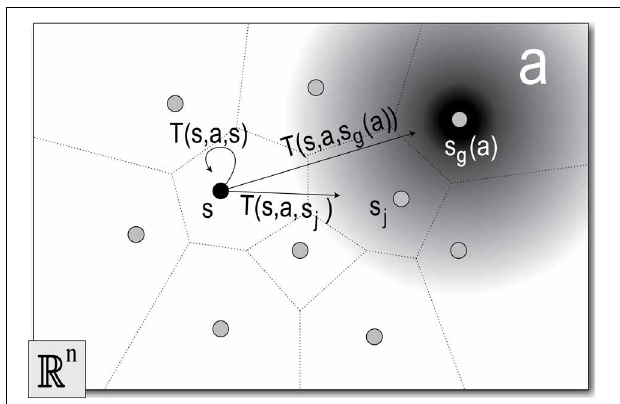
FIGURE 3 | The discrete state-action space. The sample set Q = { q j | j = 1 ... m } (dots) defines the Voronoi regions, or states S = { s j | j = 1 ... m } (bounded by dotted lines). An action a (gradient), exploits MoBeE’s attractor dynamics to pull the robot toward some goal state, s g ( a ) ∈ S . When the robot is in the initial state, q ( t 0 ) ∈ s , and the agent selects a , MoBeE switches on the attractor (Equation 1) at the point q g ∈ s g ( a ) . The agent then waits for the dynamical system to settle or for a timeout to occur, and at some time, t 1 , checks which of the states, s j contains the final real valued configuration of the robot, q ( t 1 ) . Often the state-action, ( s , a ) , terminates in the goal state s g ( a ) , but sometimes, due to constraint forces, it does not. This gives rise to a set of state transition probabilities T ( s , a ) = { T ( s , a , s (cid:7) 1 ), T ( s , a , s (cid:7) 2 ),..., T ( s , a , s (cid:7) m ) } , which correspond to the states, { s j | j = 1 ... m }